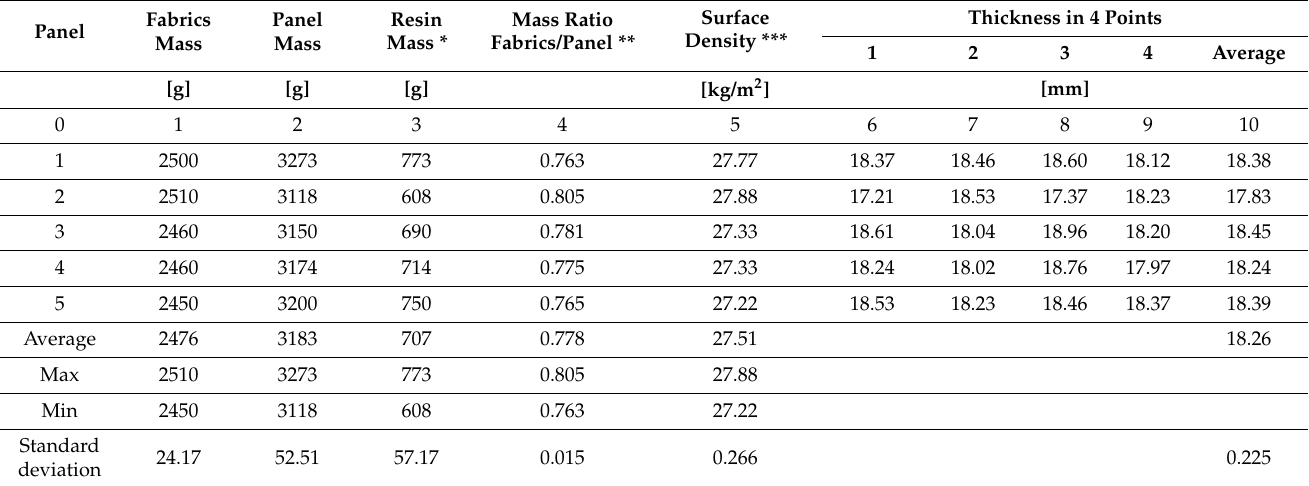
Table 4. Characteristics of the panels with 24 layers of quadriaxial glass fiber